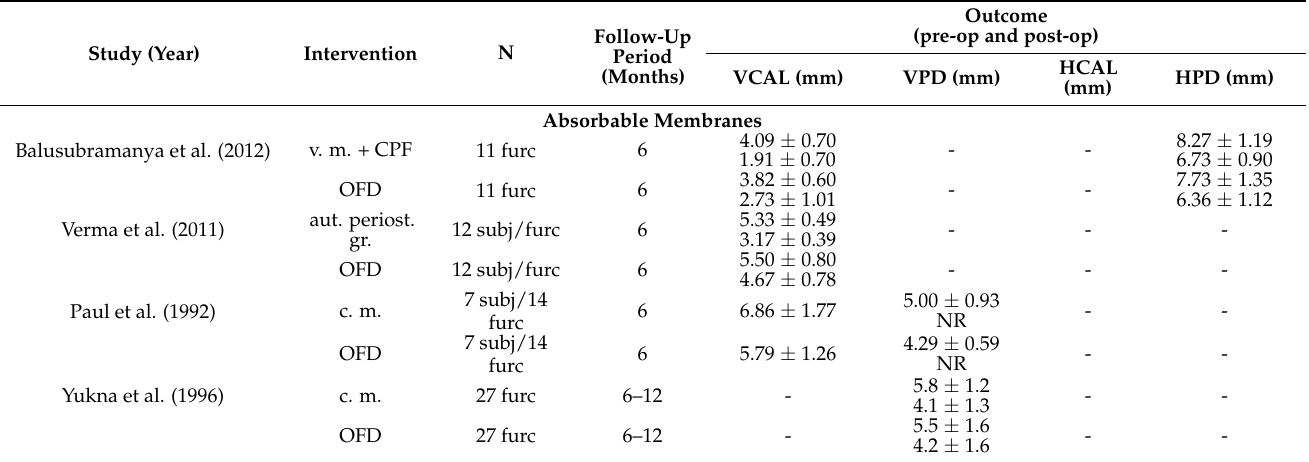
Table 4. Results reported at baseline and at follow-up in papers where absorbable membranes were